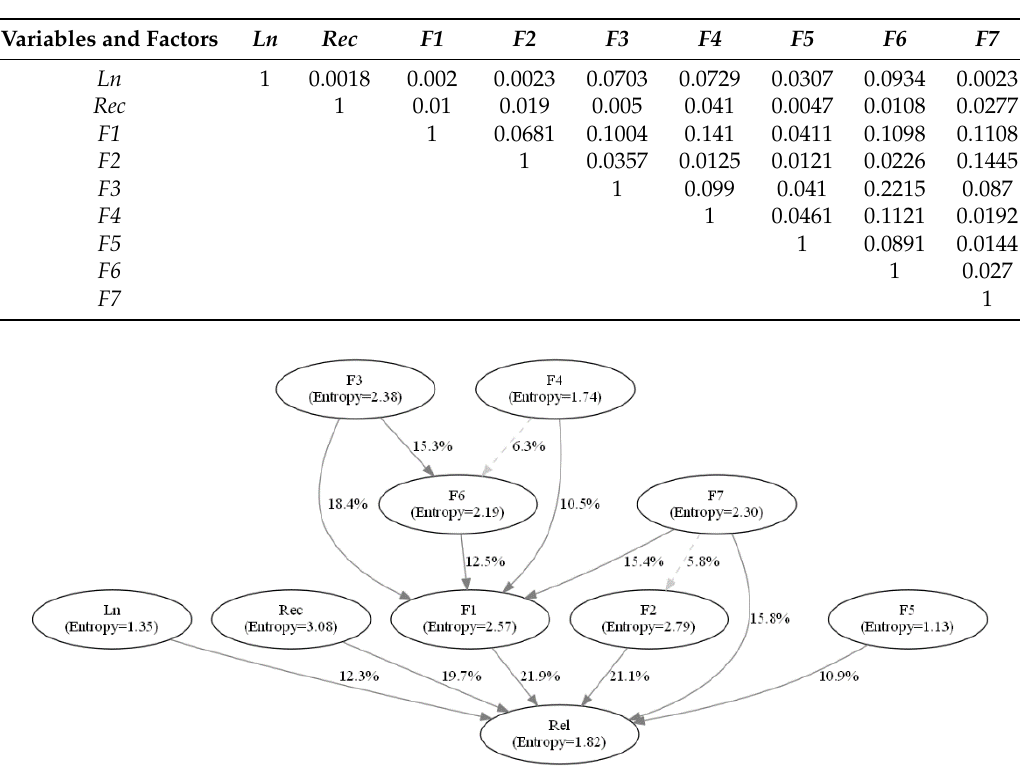
Table 5. Conditional mutual information matrix.